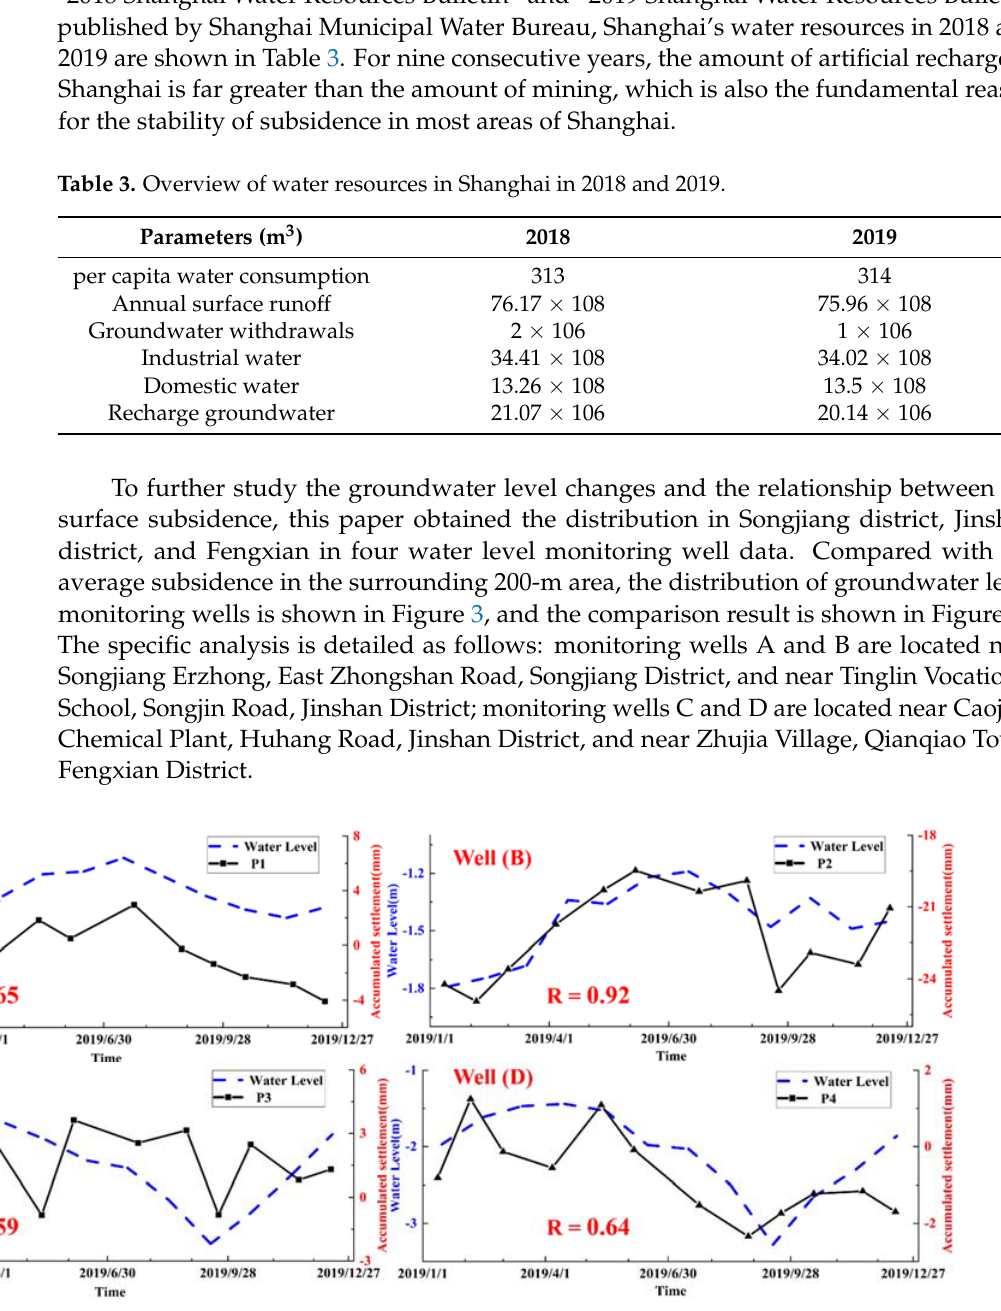
Table 3. Overview of water resources in Shanghai in 2018 and 2019.